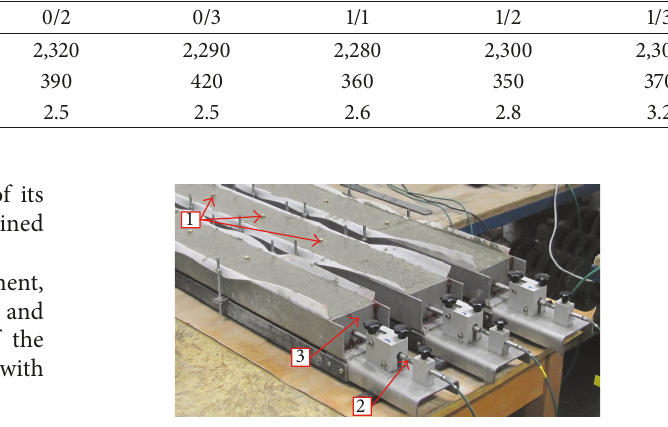
Table 3: Basic properties of fresh concretes.